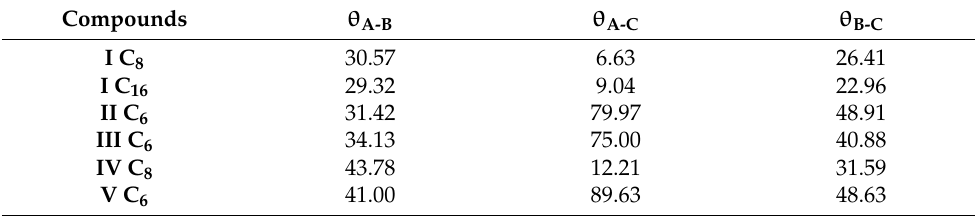
Table 2. The estimated twist angles for compounds I C 8 , I C 16 , II C 6 , III C 6 , IV C 8 , and V C 6 . Compounds θ A-B θ A-C